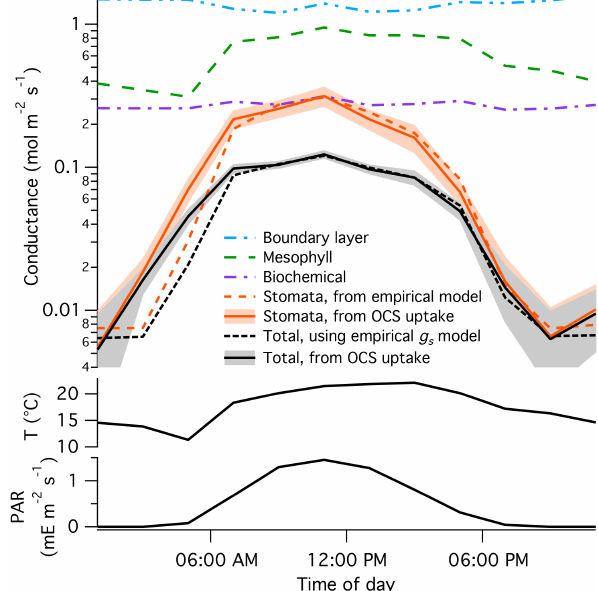
Figure 4. Composite diel cycles (including May through October of 2012 and 2013) of the expected leaf boundary layer, stomatal, mesophyll, biochemical, and total conductances to OCS transport and chemical destruction, along with the stomatal and total conduc- tances derived from OCS uptake. Lower panels show air tempera- ture and PAR for context. Lines connect the mean values of each 2h bin. Pale bands depict standard errors in the means as estimated from the variability within each bin. The boundary layer conduc- tance is likely overestimated at night (see